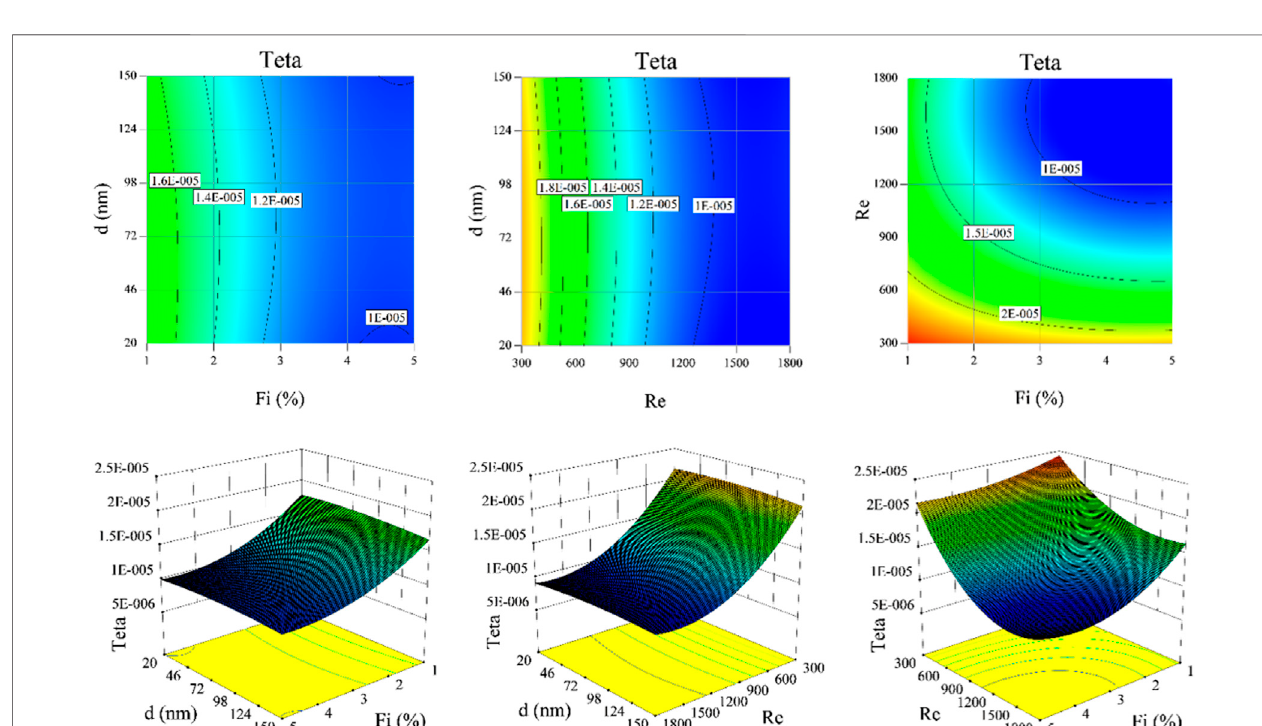
FIGURE 8 | Temperature uniformity on the bottom of the WMH-S for dissimilar values of Re , d , and Fi .